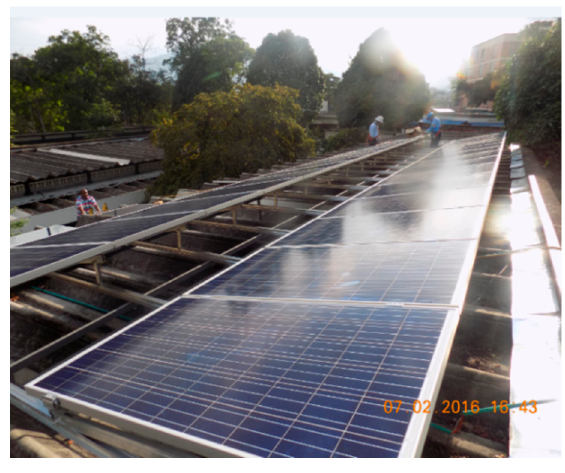
Figure 2. Photovoltaic system used. Table 1. Technical data IBC PolySol 260 CS.